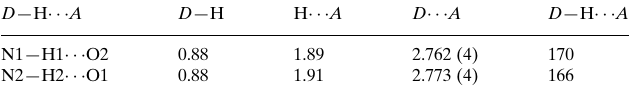
Hydrogen-bond geometry (A˚ , (cid:3)